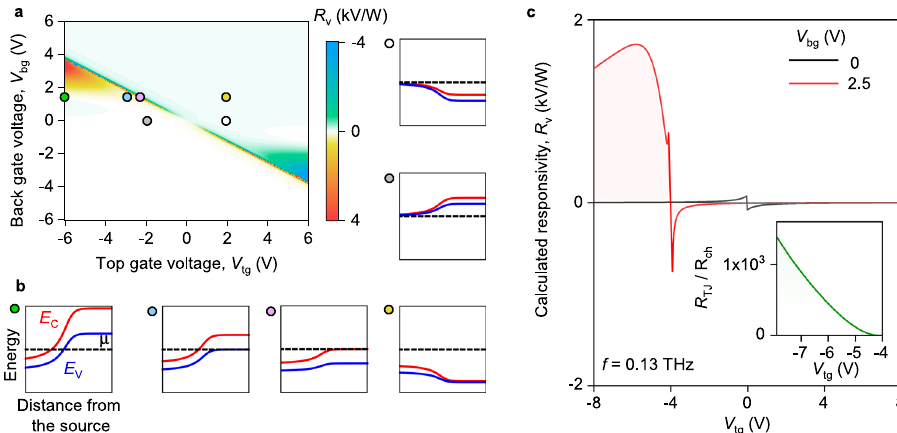
Fig. 4 Modelling tunnelling-assisted THz detection. a Calculated R v ( V tg , V bg ) map of our dual-gated BLG device in response to f = 0.13 THz radiation. b Calculated band pro fi les for different ( V tg , V bg ) con fi gurations indicated by the coloured symbols in a . White, grey, yellow, and pink symbols point to the band diagrams of the FET mode whereas the green and blue symbols correspond to the regime of interband tunnelling. Red, blue, and black lines illustrate conduction band minimum ( E C ), valence band maximum ( E V ), and the chemical potential ( μ ), respectively. c Line cuts of the map in (a) for V bg = 0 V and = 2.5 V. The radiation resistance of the antenna Z ≈ 75 Ω was used for these calculations ( “ Methods ” ). Inset: The ratio between the tunnel junction, V bg rad R R V = 2.5 TJ , contribution to the responsivity and that of the channel nonlinearity, ch , for bg